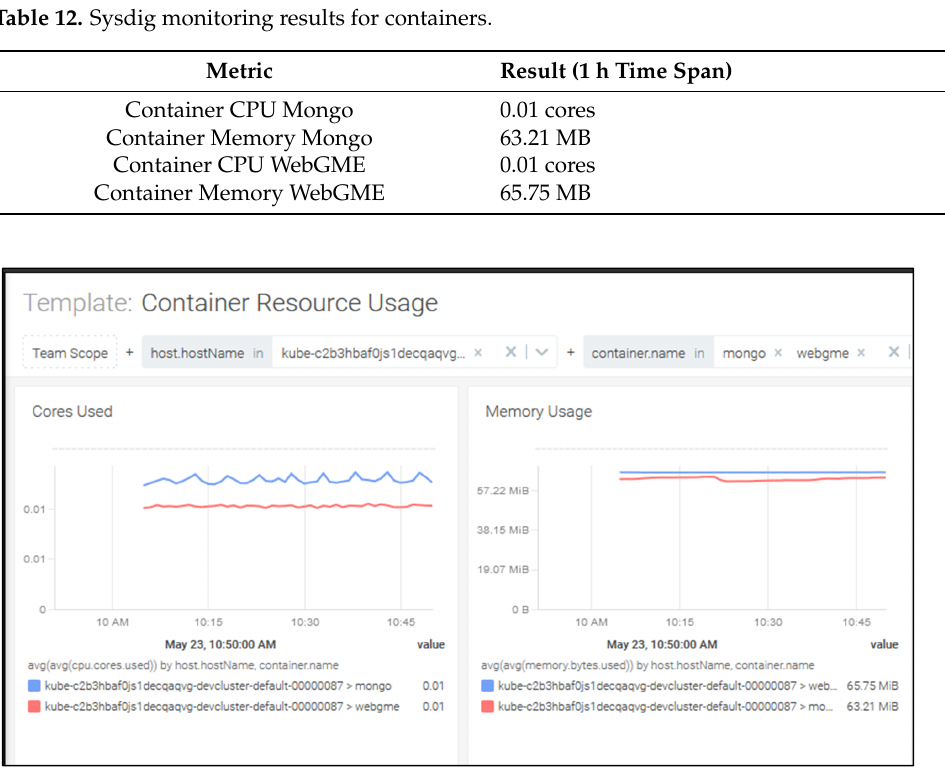
Figure 6. Sysdig monitoring dashboard.